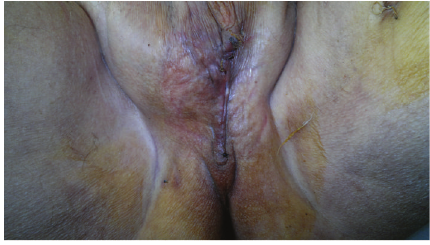
Figure 8: Perineal